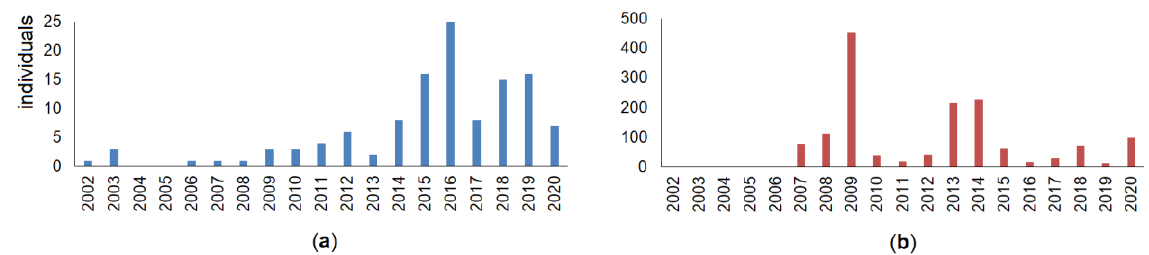
Figure 2. Raccoon dog roadkill data (individuals per year), registered by the Lithuanian Police Traffic Supervision Service in 2002–2020 ( a ) and the Nature Research Centre in 2007–2020 ( b ), datasets presenting different results both in terms of numbers and in temporal distribution of roadkills.